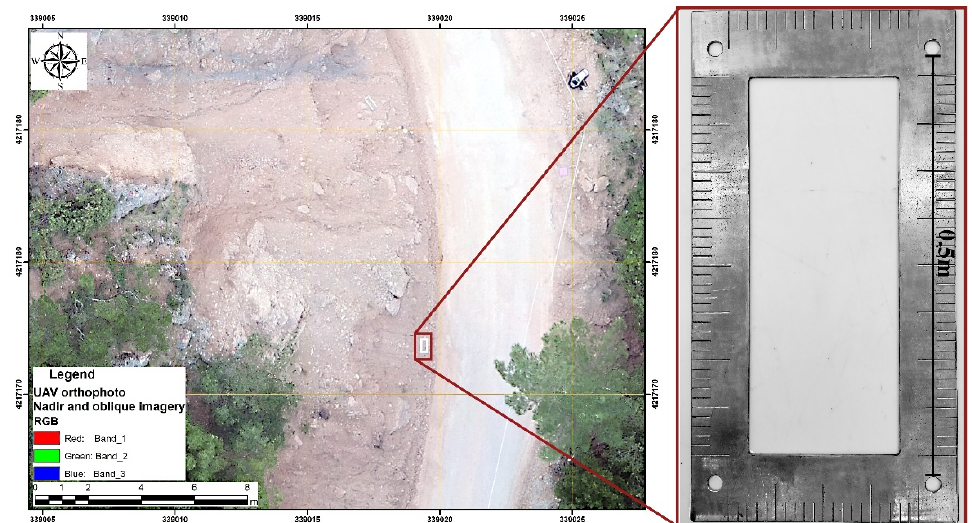
Figure 2. Printed GCP pattern, distributed throughout the survey area during UAV campaigns.